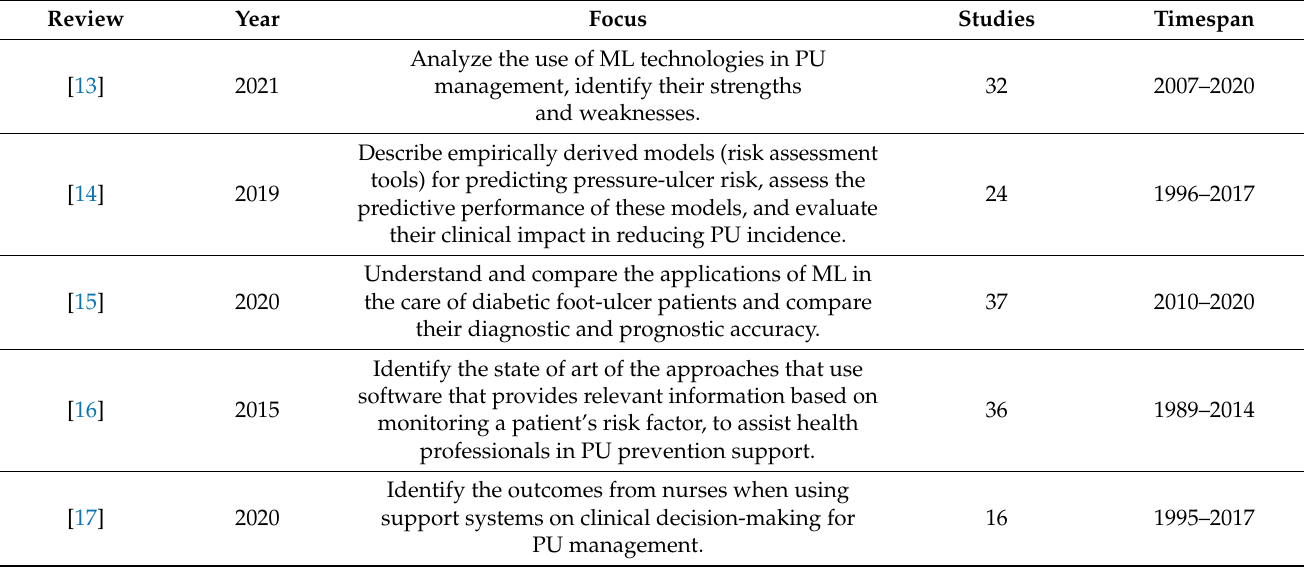
Table 1. Studies reviewing ML algorithms for PU prevention: year, focus, and